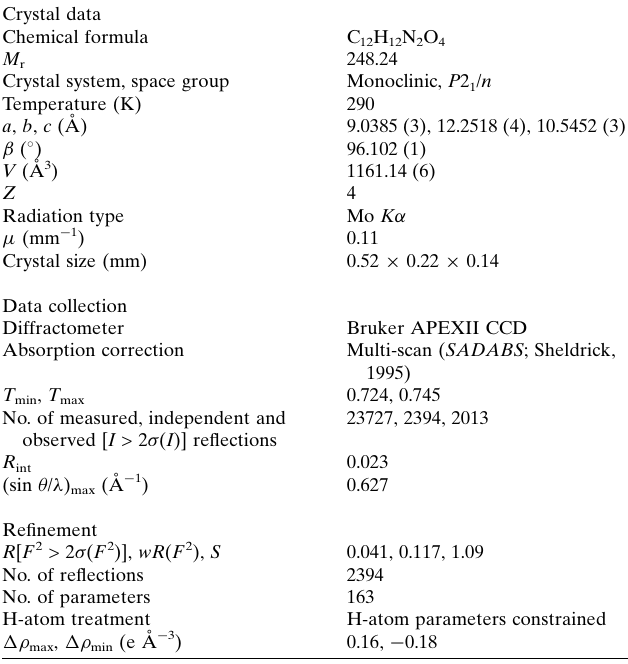
Table 4 Experimental